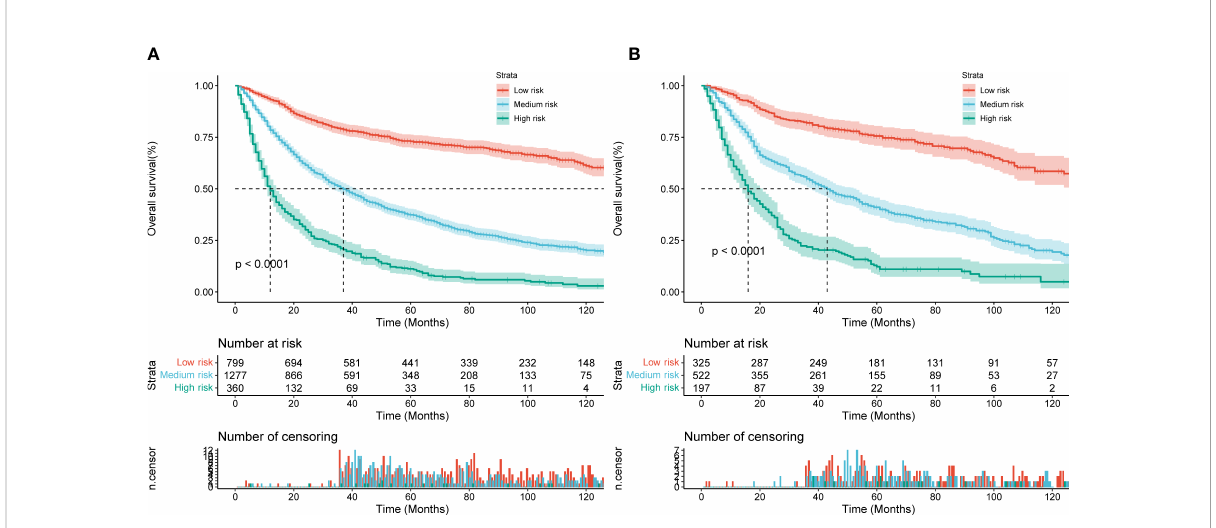
FIGURE 9 Kaplan – Meier curves of OS for patients in the low-, medium- and high-risk groups in the training Cohort (A) and validation Cohort (B)